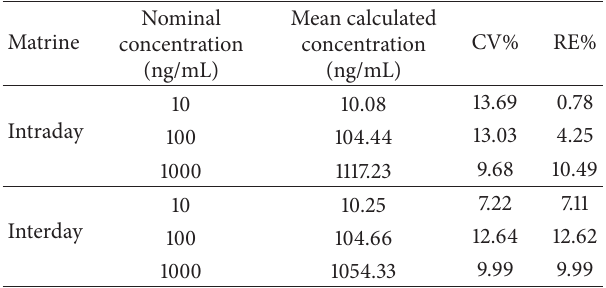
Table 1: The intra- and interday precision and accuracy of matrine ( 𝑛 = 5